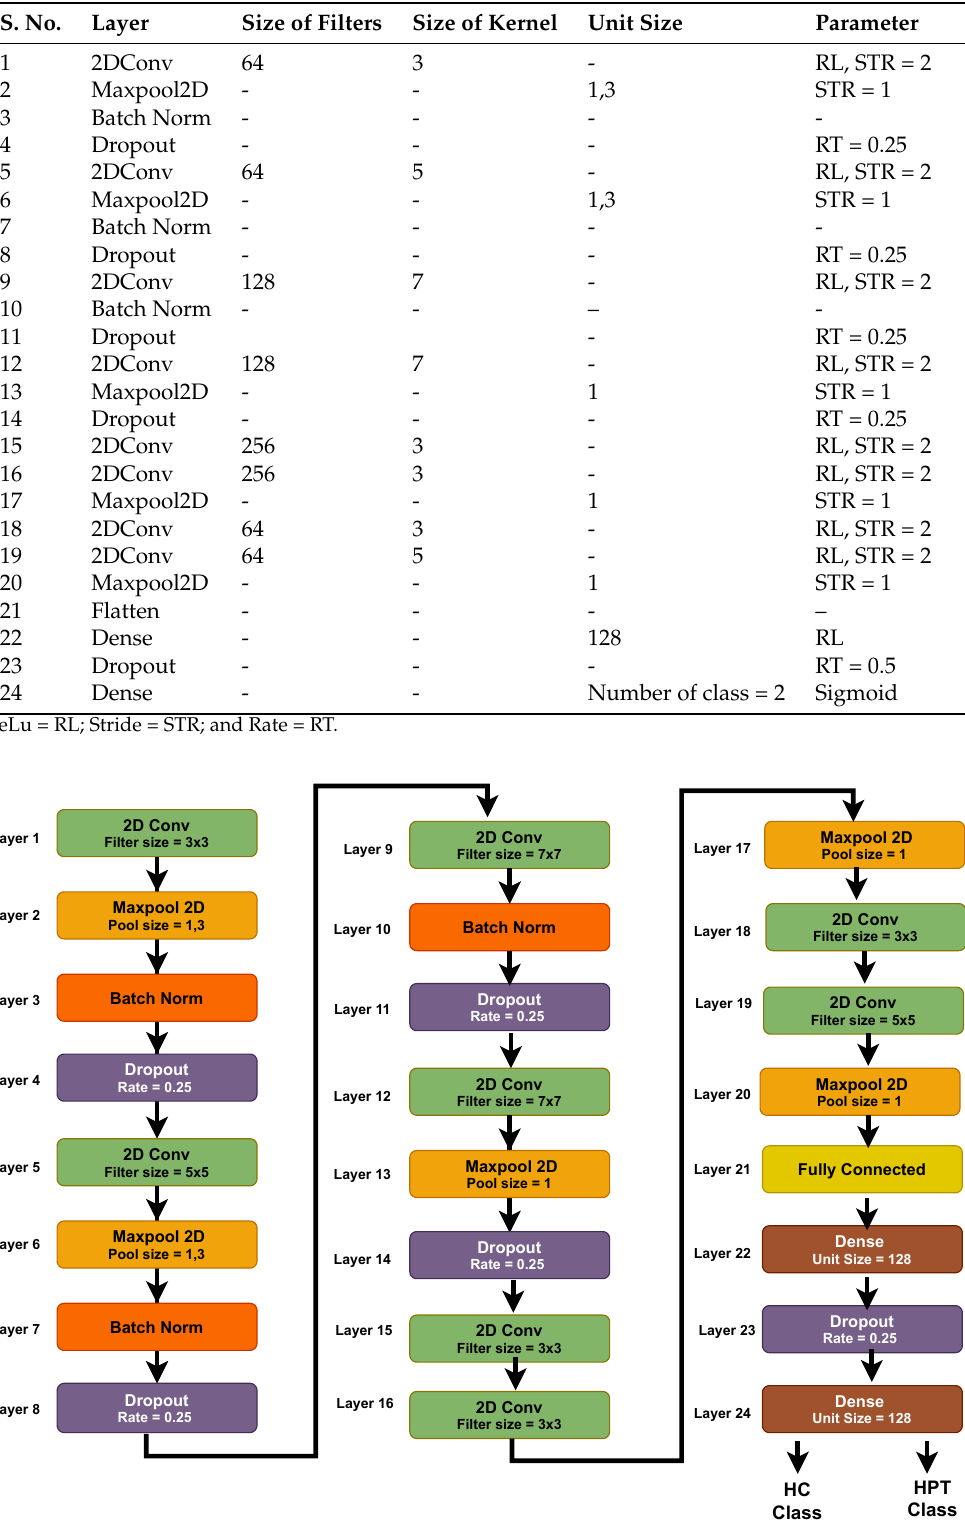
Figure 6. The proposed 2D CNN